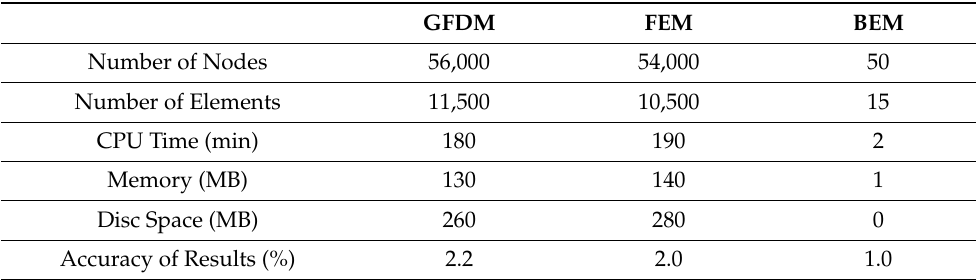
Table 2. Calculating the computational power required to model fractional bio-thermomechanical problems in FGA nonlinear viscoelastic soft tissues. GFDM FEM BEM Number of Nodes 56,000 54,000 50 Number of Elements 11,500 10,500 15 CPU Time (min) 180 190 2 Memory (MB) 130 140 1 Disc Space (MB) 260 280 0 Accuracy of Results (%)